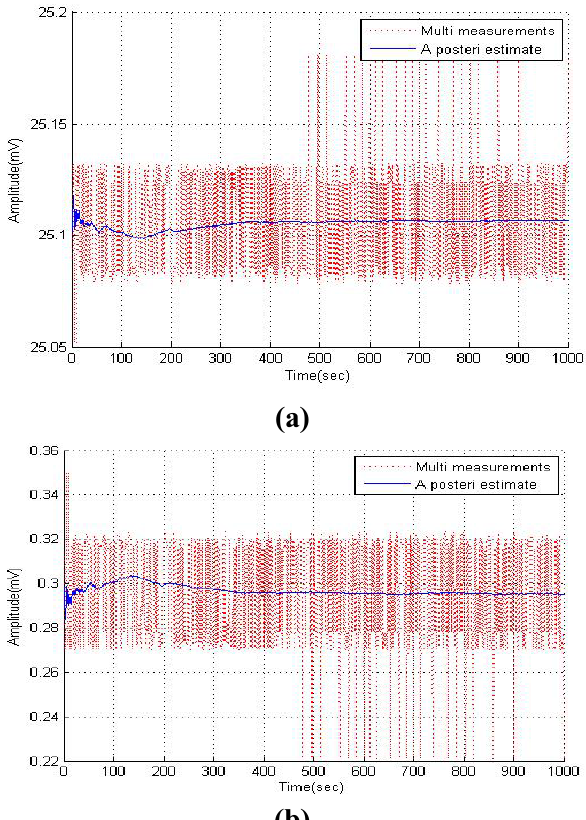
Figure 5. Simulation results of common Kalman filter. (a) Temperature sensor. (b) Humidity sensor. (c) Oxygen